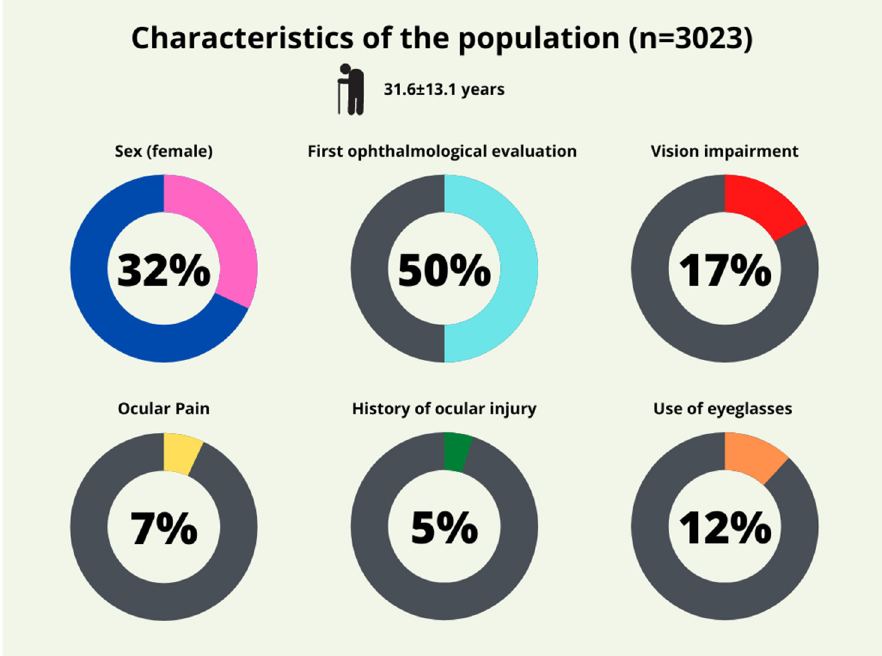
Figure 2. Main characteristics of the screened population. Of note, more than 50% of migrants underwent the first ophthalmological evaluation.